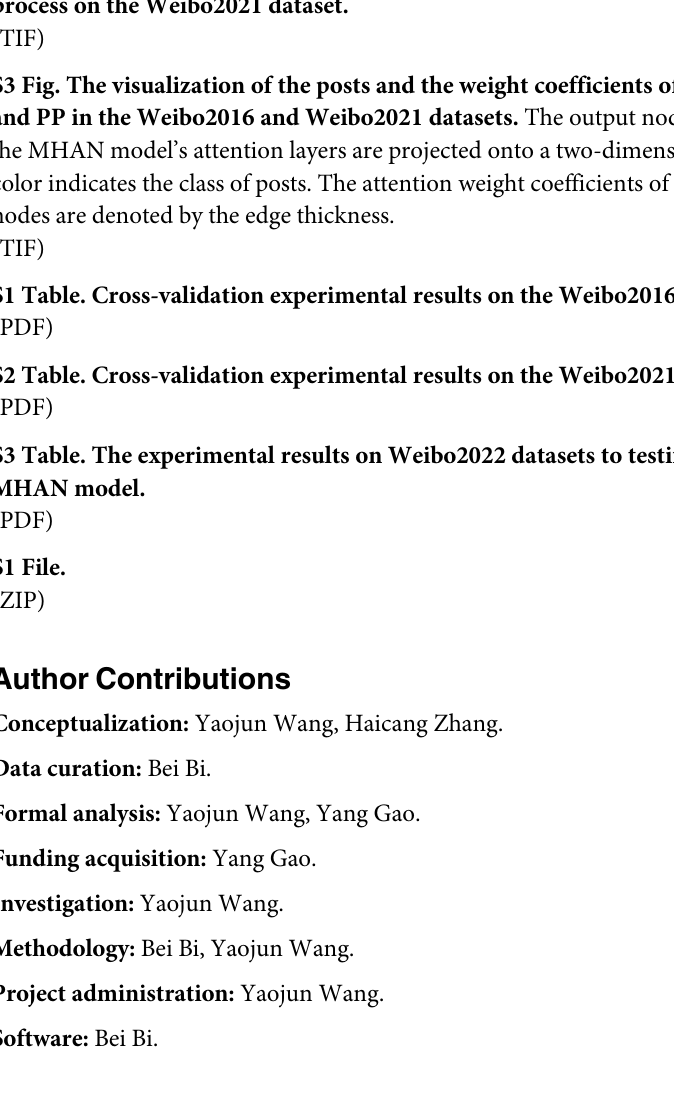
S1 Fig. The variation curve of accuracy and loss function of MHAN during the training process on the Weibo2016 dataset. S2 Fig. The variation curve of accuracy and loss function of MHAN during the training process on the Weibo2021 dataset. S3 Fig. The visualization of the posts and the weight coefficients of the meta-path PCUCP and PP in the Weibo2016 and Weibo2021 datasets. The output node features obtained by the MHAN model’s attention layers are projected onto a two-dimensional plane; the node color indicates the class of posts. The attention weight coefficients of the meta-paths between nodes are denoted by the edge thickness. S1 Table. Cross-validation experimental results on the Weibo2016 dataset. (PDF) S2 Table. Cross-validation experimental results on the Weibo2021 dataset. (PDF) S3 Table. The experimental results on Weibo2022 datasets to testify the universality of the MHAN